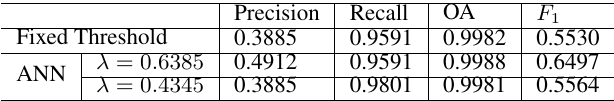
Table 5. Result comparison of two